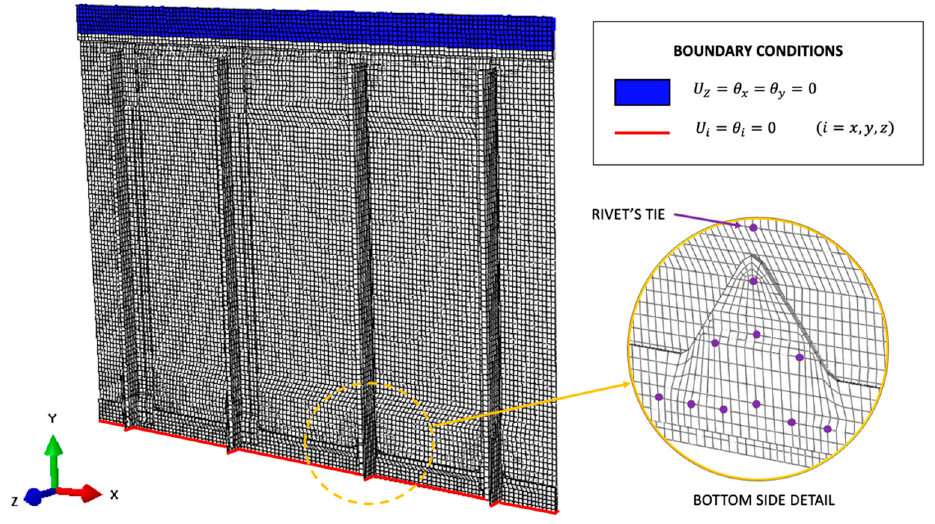
Figure 8. Complete inverse Finite Element Method (iFEM) model.